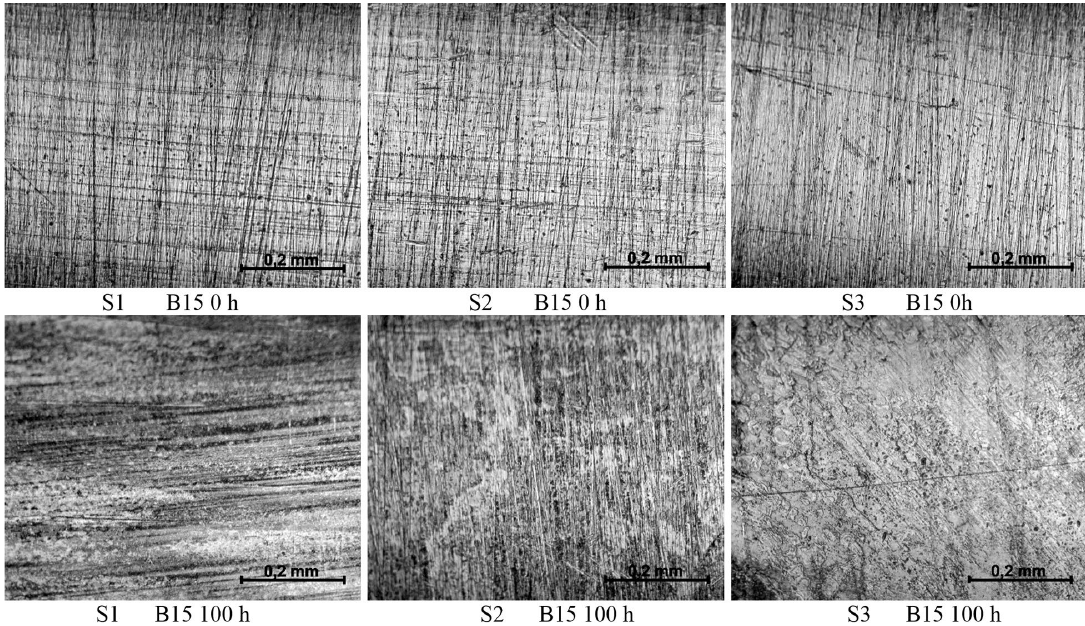
Fig. 7. The pictures of plungers surfaces S1, S2, S3, working with B15 fuel